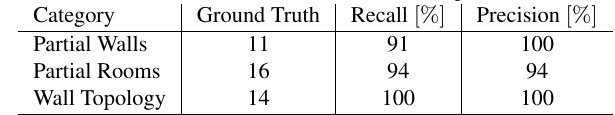
Figure 3: Overview workflow wall topology with partial walls in grey, floors in red, affected walls in green and changes in yellow: Intersections partial walls (a), trim overextend walls (b), extend walls horizontally (c) and extend walls vertically (d). Table 1: Properties Multi-storey School Facility Table 2: Results of intermediate steps